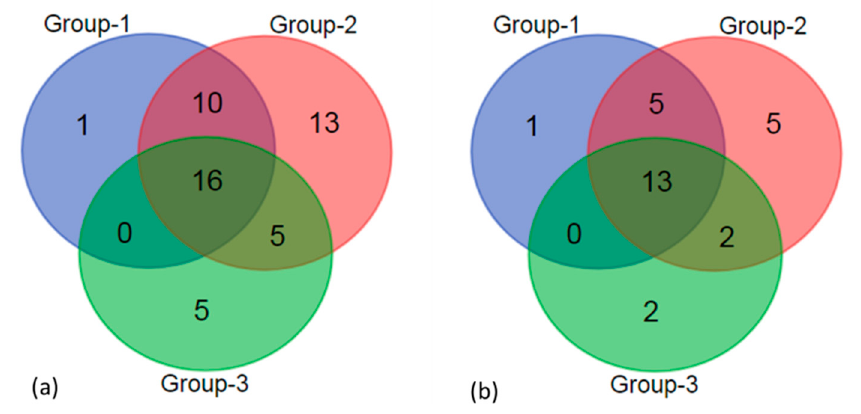
Figure 3. Venn diagram of the richness of diatom at species-level ( a ) and genus-level ( b ).